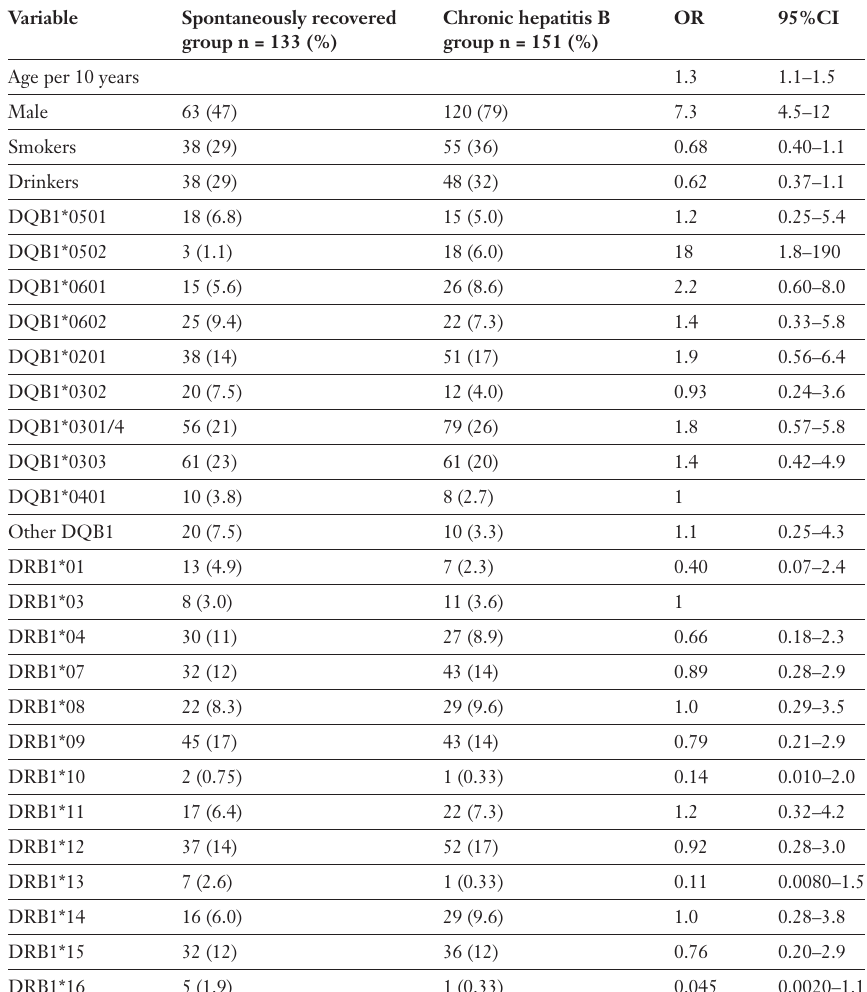
Table 5 Logistic regression model for chronic hepatitis B given pa- tient demographics and alleles of HLA- DQB1 and